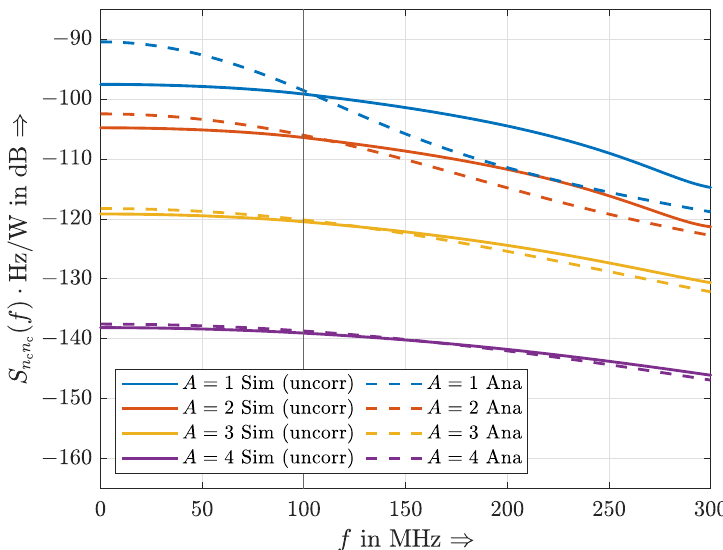
Figure 8. Simulated (solid line) and analytical (dashed line) power spectral density of the clipping distortion for σ 2 x = 1, B = 200 MHz and different clipping levels A .